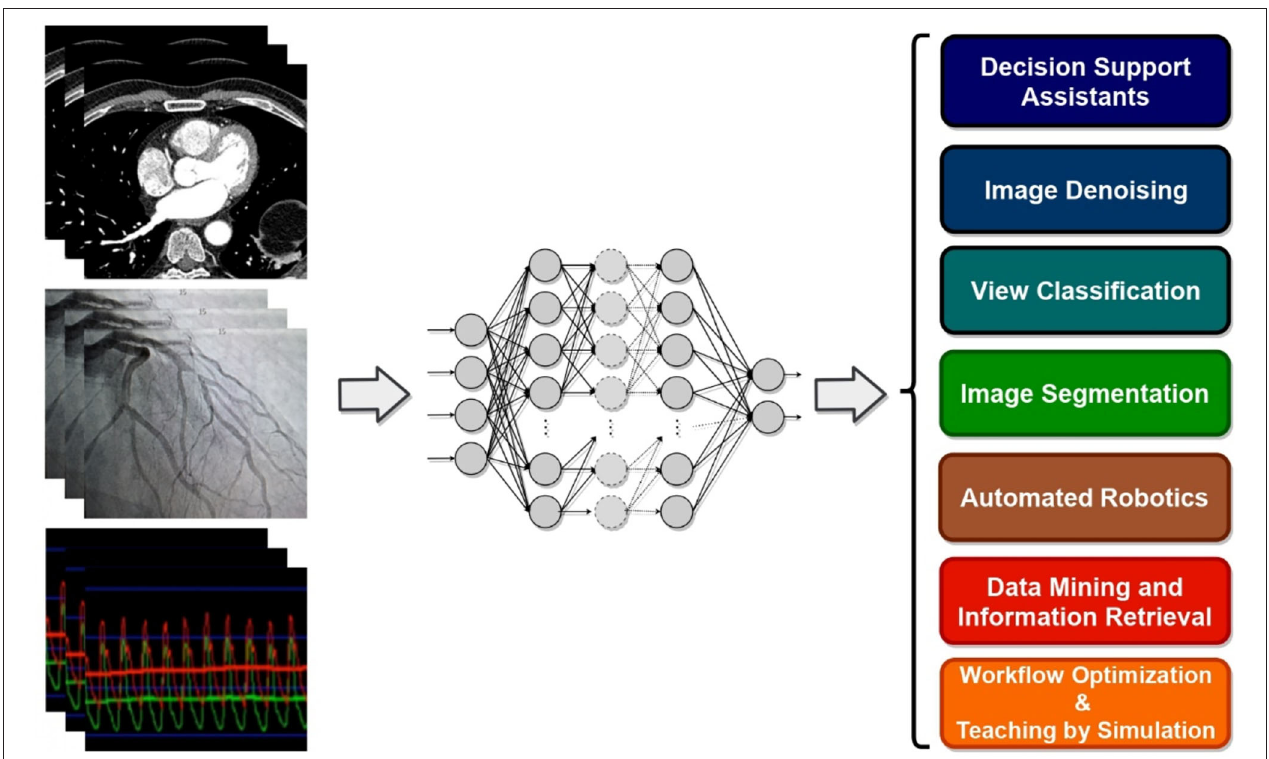
FIGURE 2 | Domains of implementation of machine learning tools to